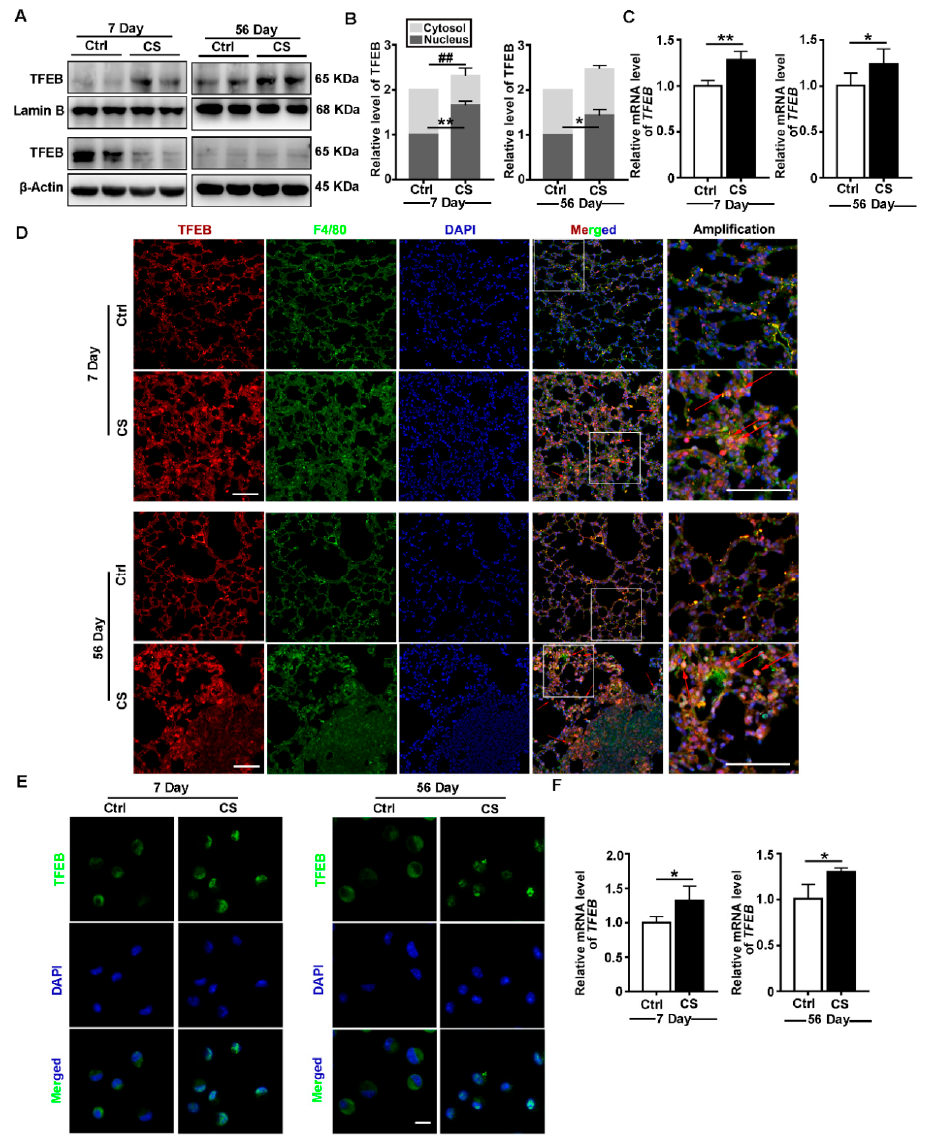
Figure 1. Crystalline silica (CS) induces transcription factor EB (TFEB) nuclear localization and increases TFEB expression in vivo. ( A , B ) Immunoblotting analysis of TFEB levels in the cytosol or nucleus of lung tissue on day 7 or day 56 post CS instillation; β‐ actin, loading control for cytosolic proteins; and lamin B, loading control for nuclear proteins ( n = 4). ( C ) qPCR analysis of TFEB expression in lung tissue on day 7 or day 56 ( n = 5 to 6). ( D ) Immunofluorescence analysis of the distribution of F4/80 and TFEB in lung tissue on day 7 or 56 post saline or CS treatment. Red arrows indicate alveolar macrophages (AMs) in the lungs containing silicotic lesions with predominantly nuclear TFEB staining (scale bar = 50 μ m and n = 5). ( E ) Immunofluorescence analysis of TFEB nucleus translocation in primary AMs from bronchoalveolar lavage fluid (BALF) (scale bar = 10 μ m and n = 3 to 4). ( F ) qPCR analysis of TFEB expression in primary AMs on day 7 or 56 post CS instillation ( n = 4). Data are presented as the mean ± SD. *, p < 0.05; **, p < 0.01; and ##, p < 0.01. 3.2. TFEB Modulates CS ‐ Induced Macrophages Apoptosis and Secretion of Inflammatory Cytokines In Vitro Because nuclear localization of TFEB was observed in AMs in vivo after CS treatment, we explored the effects of CS exposure on TFEB in vitro. Consistent with the in vivo data, expression of